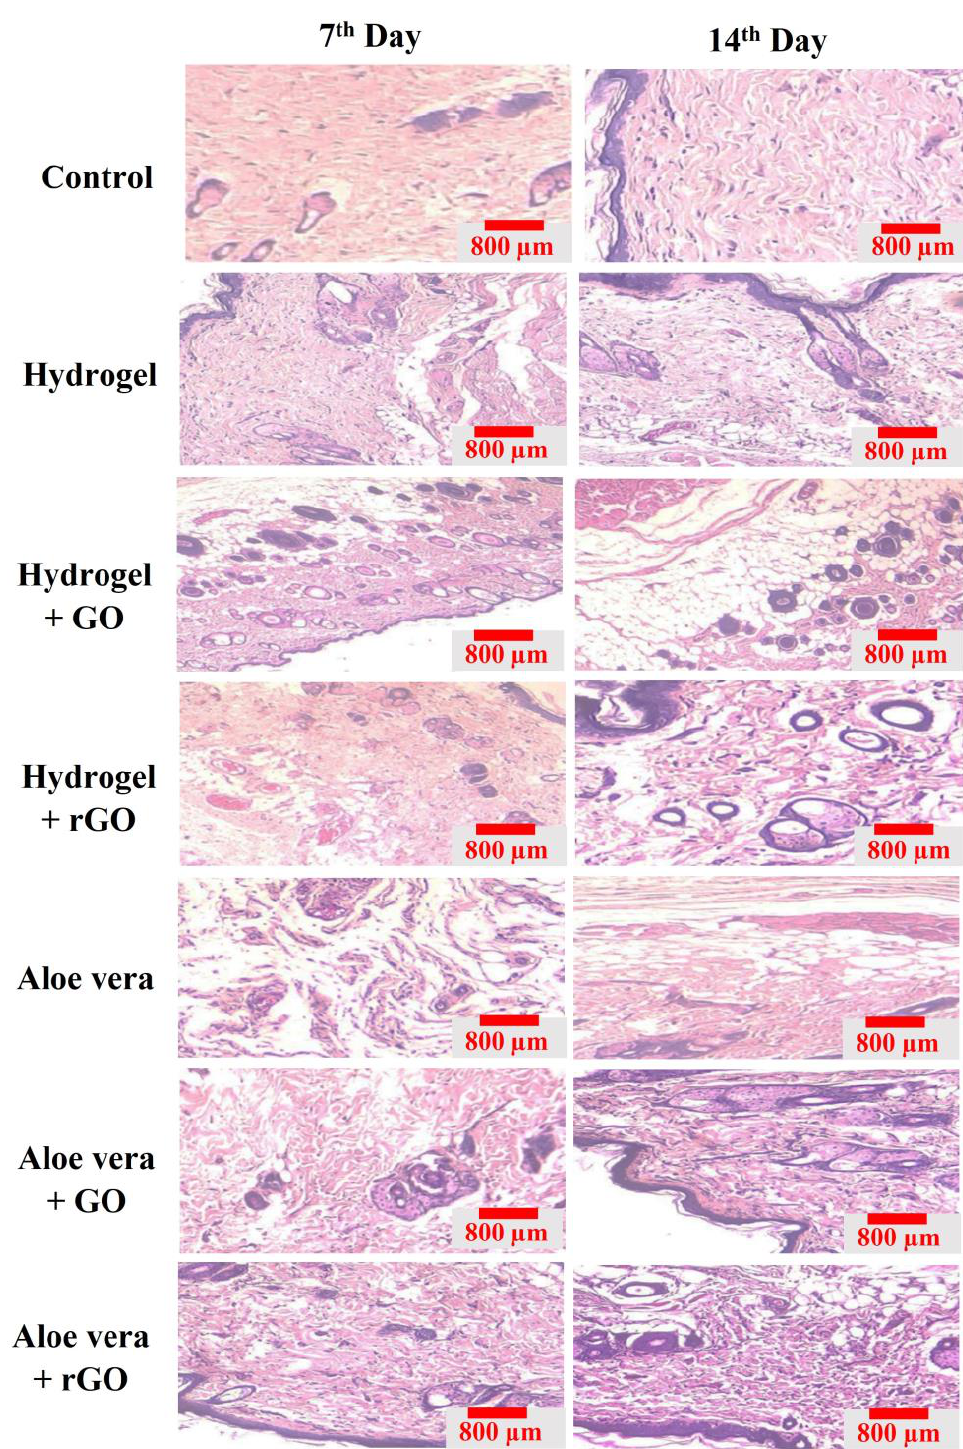
Figure 17. H&E stained granulation tissues of GO and rGO-based composite gels on the 7th and 15th days. Day 7 and Day 15 tissue samples stained with H&E stain from the treatment groups showed the formation of the epithelial tissue layer, the presence of dense polymorphonuclear cells, and blood vessel formation.